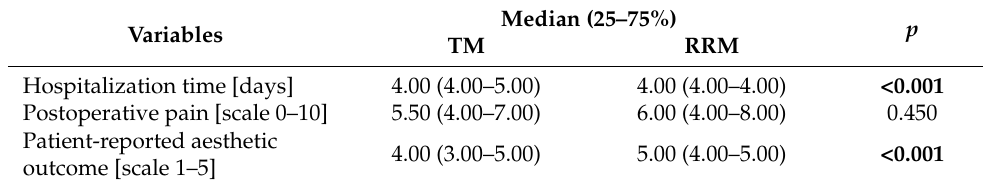
Table 3. Surgery outcomes after therapeutic and risk-reducing